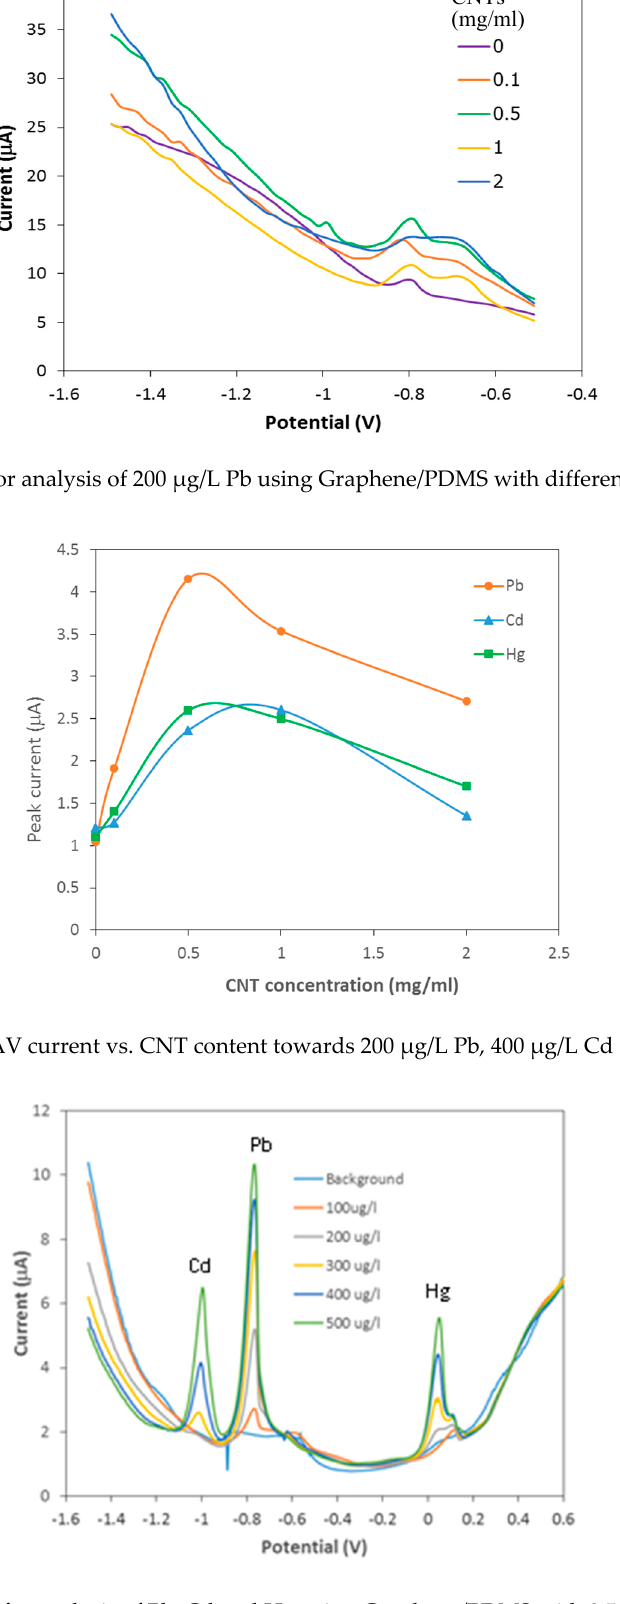
Figure 5. DPASV for analysis of Pb, Cd and Hg using Graphene/PDMS with 0.5 mg/mL